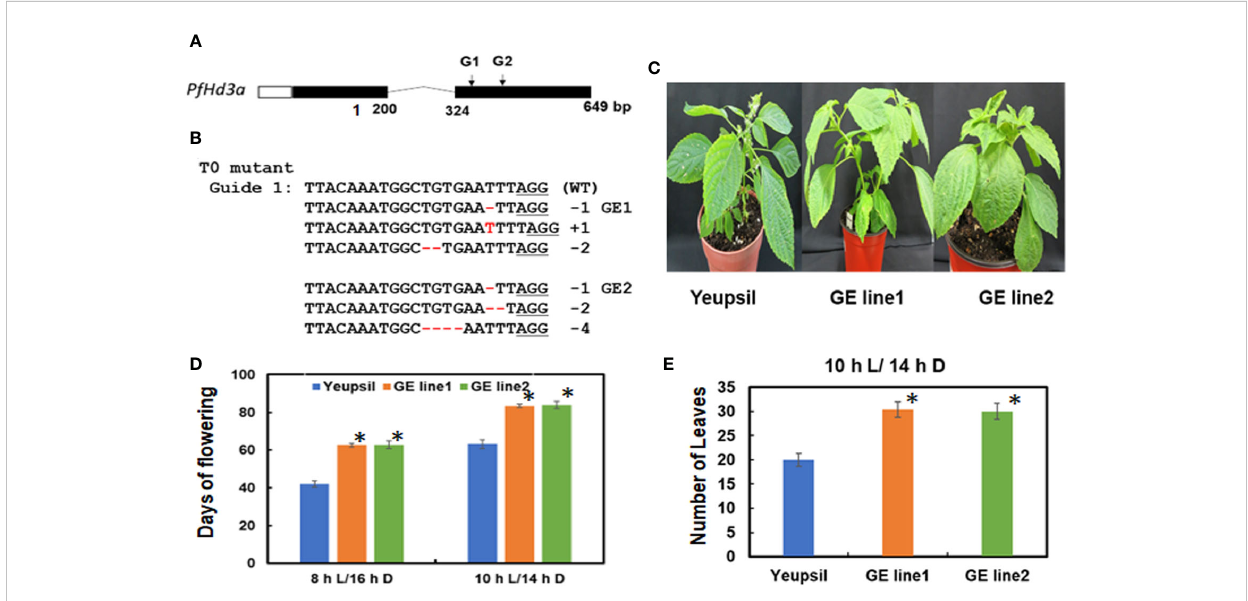
FIGURE 6 PfHd3a GE perillas enhance leaf productivity. (A) Schematic representation of PfHd3 a locus. White, black boxes and curved lines represent 5 ’ - untranslated regions (5 ’ UTR), coding sequence, and intron, respectively. (B) The aligned NGS reads fl aking the PfHd3a target site and numbers represent the number of bases deleted and inserted in the T 0 line. (C) The late- fl owering phenotype of GE perillas. (D) Flowering times were determined as days of fl owering after sowing at the time of fl owering under SD (both 8 h light/16 h darkness and 10 h light/14 h darkness) conditions. At least 12 plants of each genotype were used. Statistical signi fi cance was determined by Student ’ s test (*P < 0.001). (E) Number of leaves were counted at the time of fl owering under SD (10 h light/14 h darkness) condition. At least 12 plants of each genotype were used. Statistical signi fi cance was determined by Student ’ s test (*P <